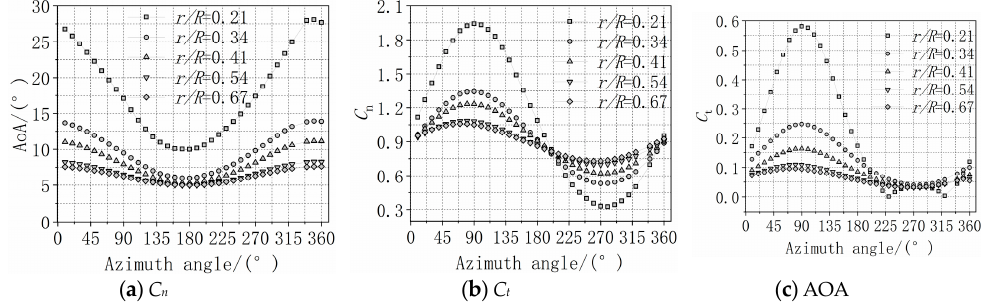
Figure 13. Azimuthal aerodynamic loads at different spanwise sections during one revolution under a yaw angle of 30°.